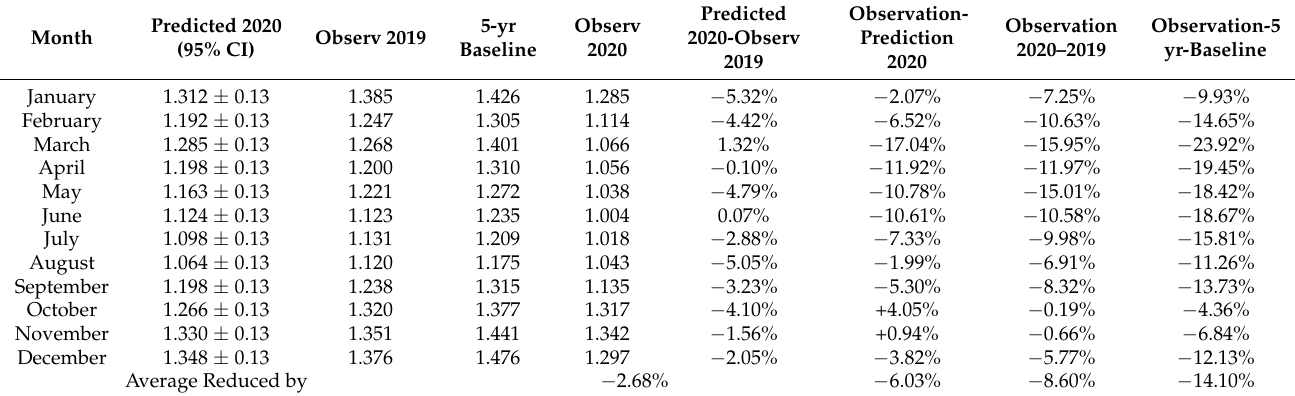
Table 1. Comparison of results between observations and expected trend.